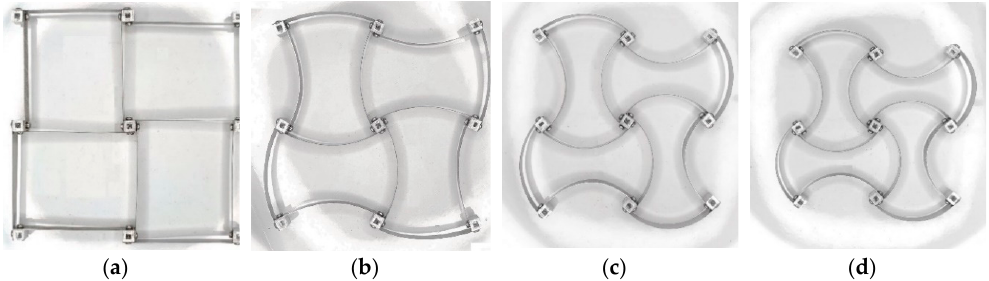
Figure 12. Recorded deformed shapes of a sample with L = 54.9 mm (refer to Figure 11) at four different temperatures ∆𝑇 : ( a ) 0 ℃ , ( b ) 65 ℃ , ( c ), 85 ℃ ( d ), 136 ℃ . The measured thermal strain values matched the theoretical curves well, as can be seen from the Figure 13 plot. Given a 4% uncertainty in the a -value measurement, Equation (17), plus an estimated ±0.01 systematic thermal strain error due to geometrical imperfections of the samples, this match can be considered very good. This proves validity of the theoretical analysis approach discussed in Sections 2.1–2.5. The observed thermal strain dependence on temperature corresponds to a thermal expansivity, whose values can be best seen from the earlier Figure 5 plot. For the temperature range of ∆𝑇 from 0 ℃ to 130 ℃ , it is in the range of negative 0.0006–0.0041 °C − 1 . The initial thermal expansivity (at ∆𝑇 ≈ 0 ℃ ) is the range of negative 0.0006–0.0007 °C − 1 , depending on the value L .